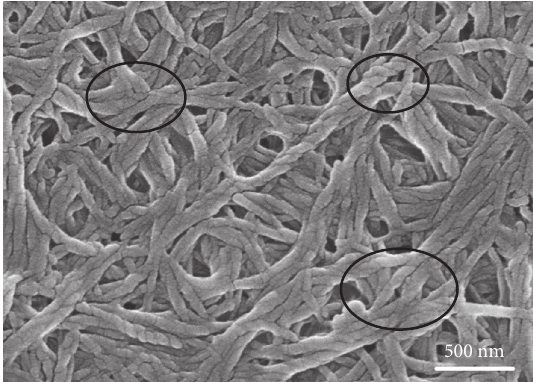
Figure 4: Micromorphology of NLGI 1 lithium-based lubricating